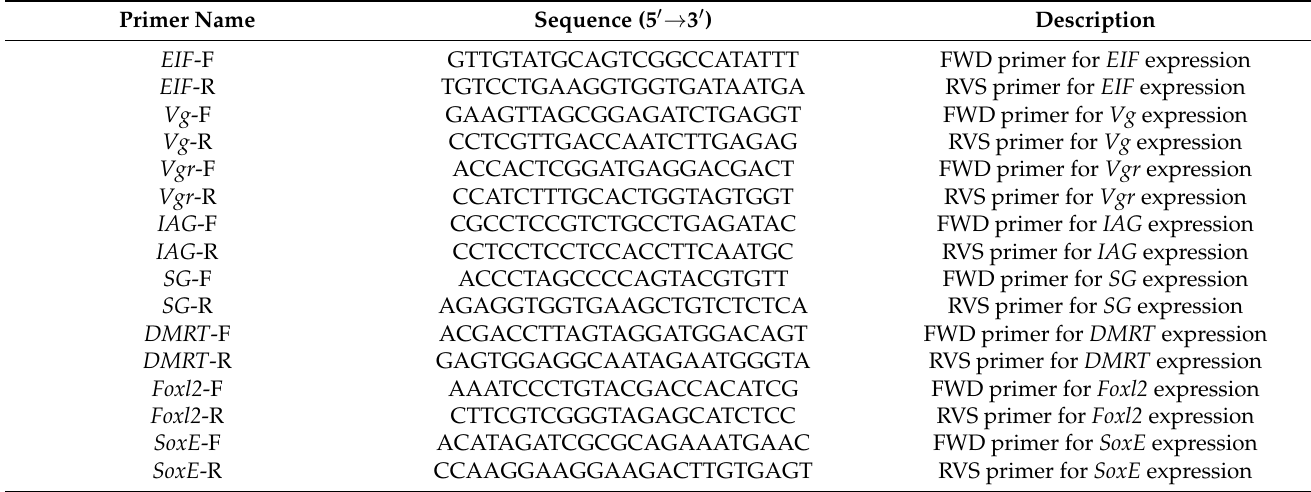
Table 3. Sequences of primers